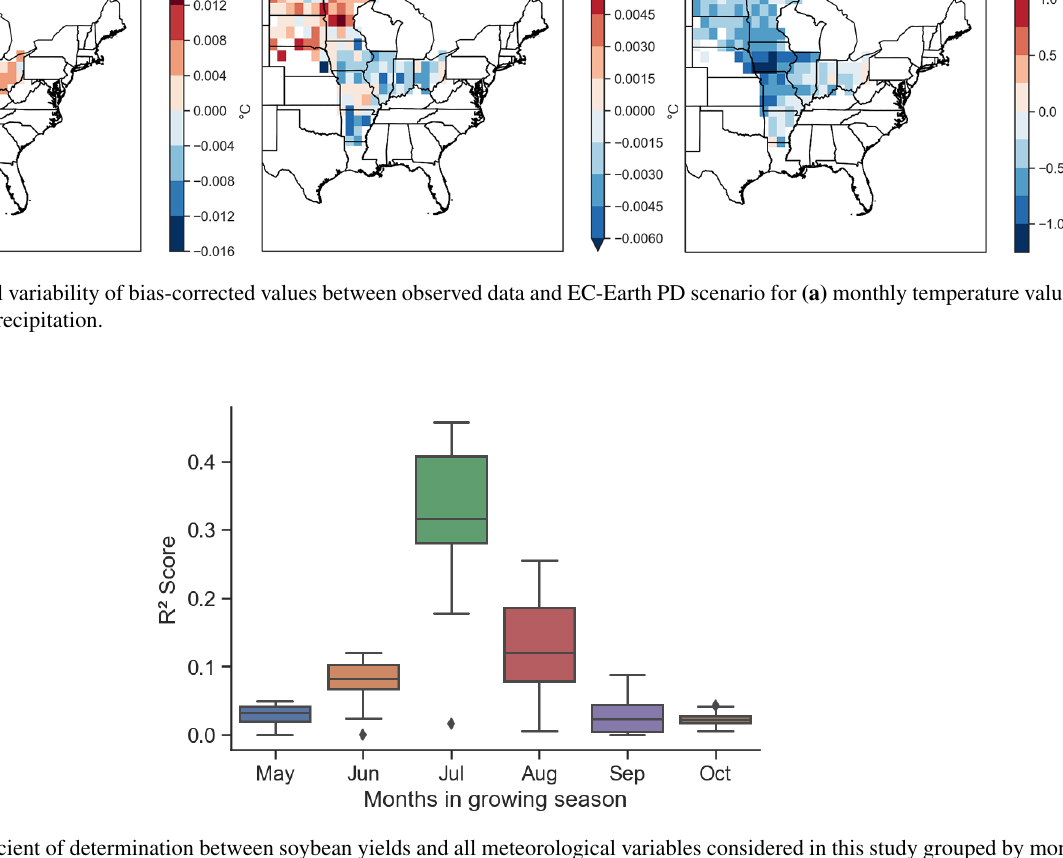
Earth Syst. Dynam., 12, 1503–1527,